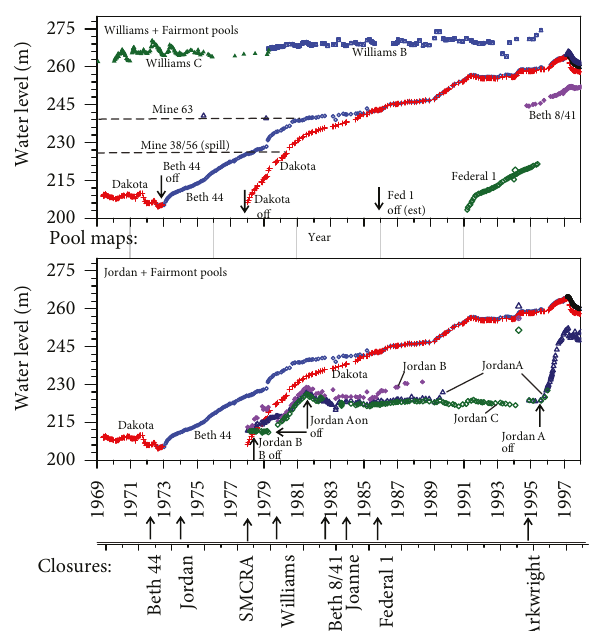
Figure 8: Water level hydrographs in Williams, Fairmont, and Jordan pools, 1969 – 1998. Labels and symbols refer to water levels at individual monitoring wells within the speci fi ed mines (see Tables 1 and 2). Grey bars between plots refer to dates of fl ooding maps, Figures 6 and 7.